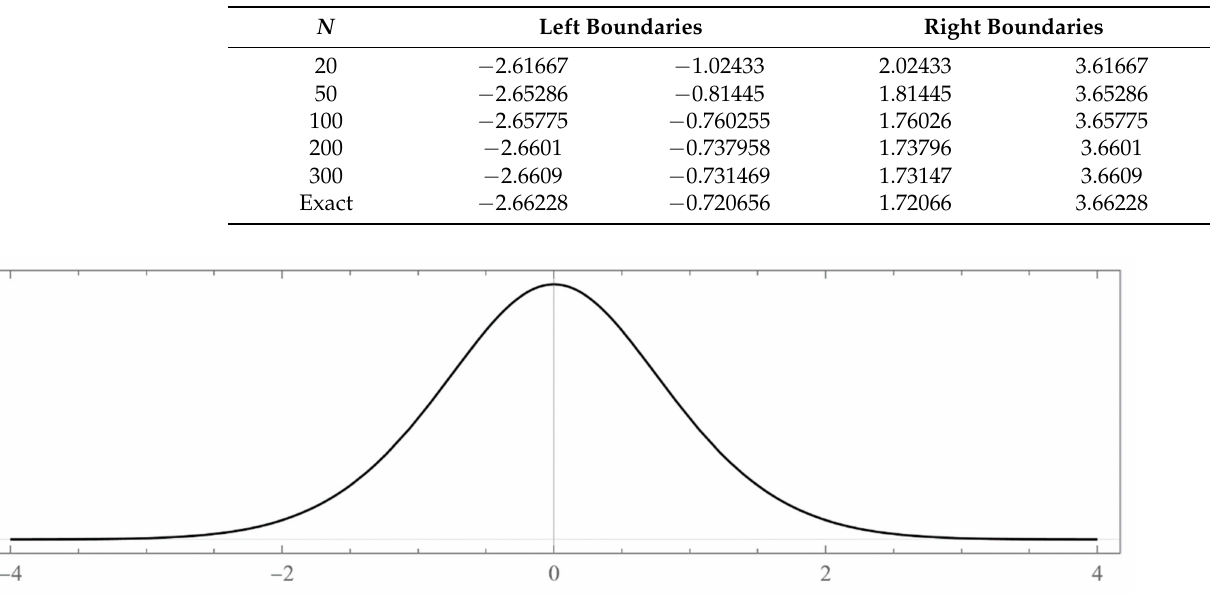
Table A3. The left and right boundaries of the left and right energy bands in units of λ 2 for different values of N . The exact values are in (12).